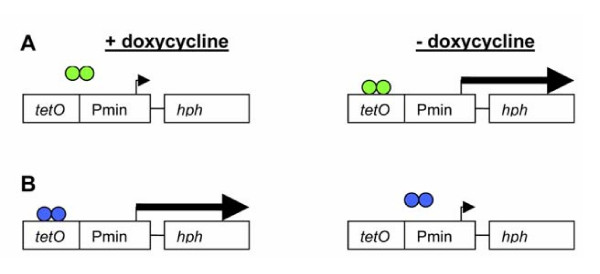
Schematic overview of the tetracycline-regulated gene expression system used in this study. The hygromycin resistance gene, hph, is under the control of seven copies of the TetR binding sequence, tetO, linked to a minimal promoter (Pmin). In the tTA-dependent expression system (A), the tTA protein (green circles) promotes hygromycin resistance of A. fumigatus by binding to the tetO promoter and activating transcription of the hph gene. Incorporation of doxycycline into the medium prevents tTA from binding to tetO, resulting in hygromycin sensitivity due to the absence of hph expression. The reverse tTA system (B) takes advantage of a reverse tetracycline transactivator, rtTA (blue circles), that binds to the tetO promoter only in the presence of doxycycline. In this case, rtTA promotes hygromycin resistance of A. fumigatus only when grown in the presence of doxycycline.